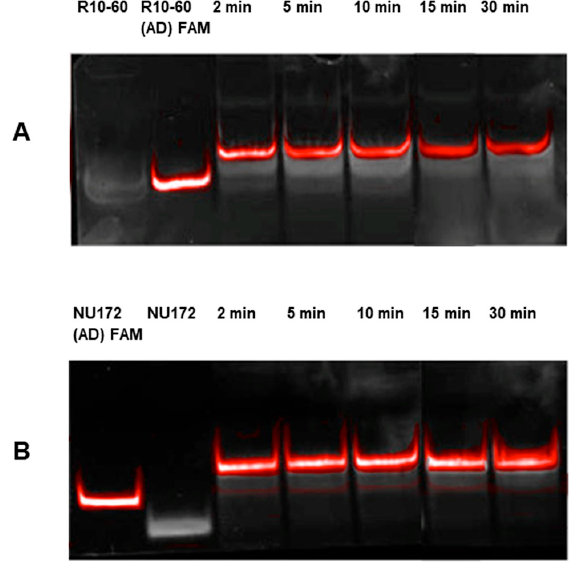
Figure 1. Determination of the time required for the formation of aptamer/antidote (AD) complexes using 10% nondenaturing polyacrylamide gel electrophoresis. Samples were analyzed after 2, 5, 10, 15, and 30 min of incubation in human serum. ( A ) Analyses of R10-60/R10-60 (AD) FAM complexes; ( B ) Analyses of NU172/NU172 (AD) FAM complexes. Firstly, FAM-labeled ADs were detected using UV-transilluminator (red colored bands) and then all oligonucleotides were detected using GelRed™ staining (white colored bands). An overlay of FAM and GelRed staining is presented.